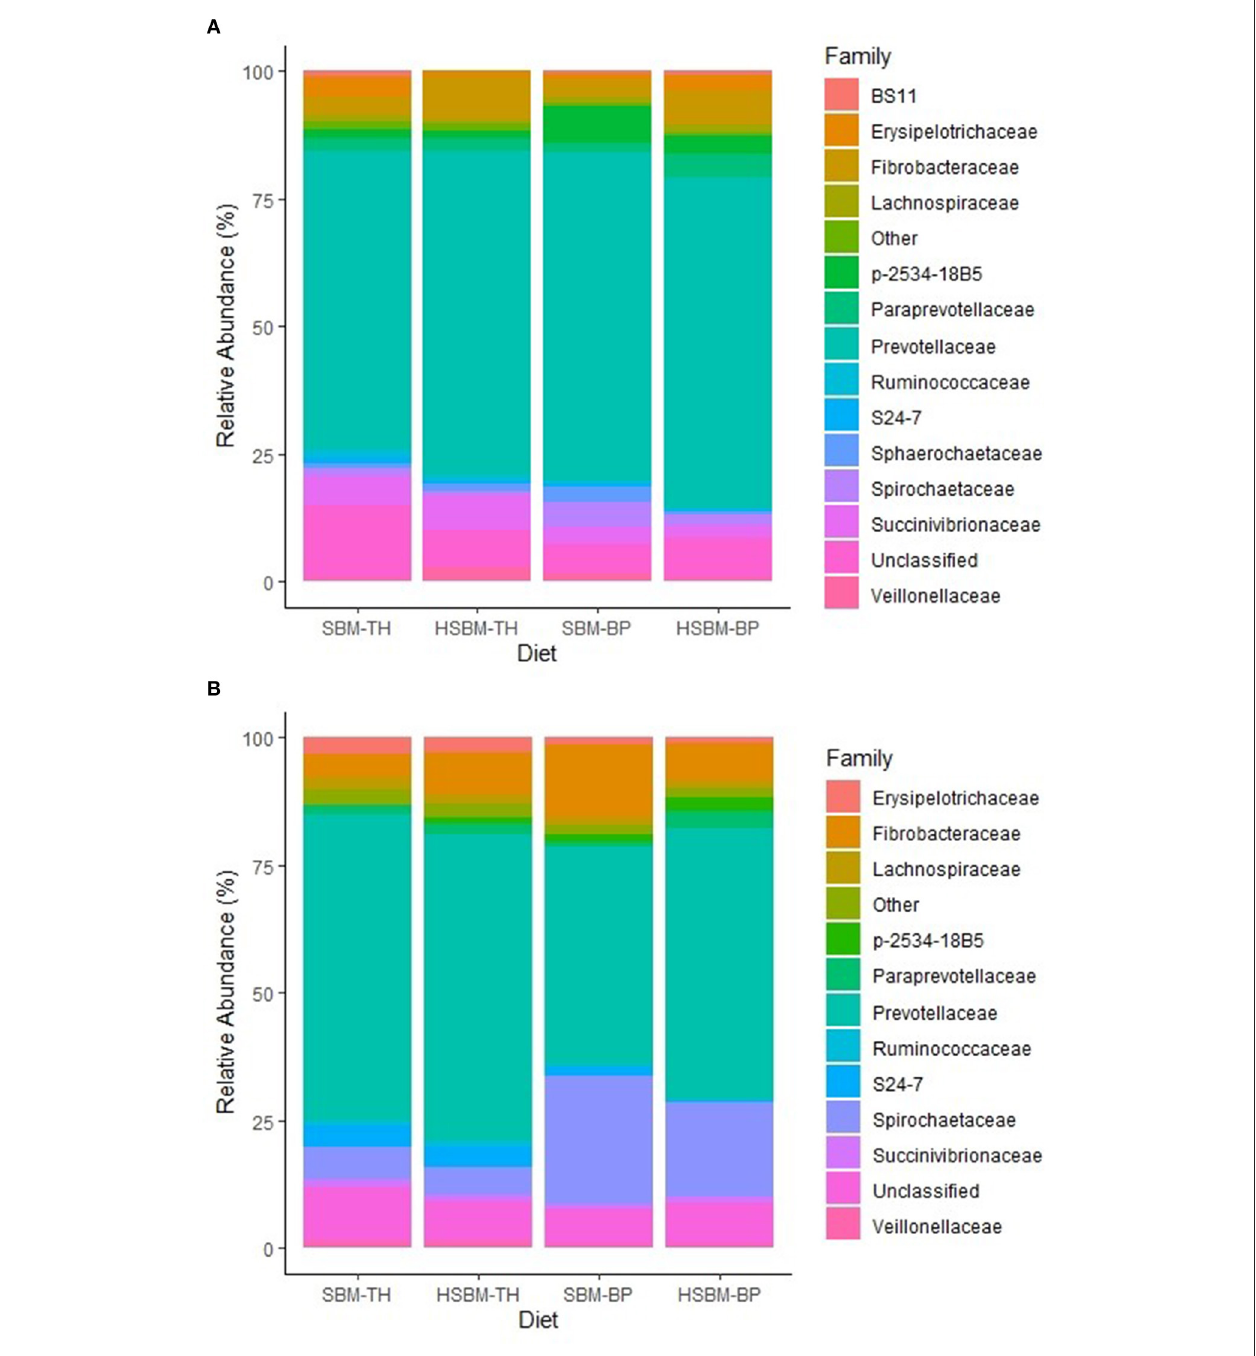
FIGURE 2 | (A) Family-level composition of bacteria identified in the rumen fluid fraction as differentiated by diet. The category “Other” is comprised of taxa with relative abundances < 1.0% for all diets. (B) Family-level composition of bacteria identified in the rumen solid fraction as differentiated by diet. The category “Other” is comprised of taxa with relative abundances < 1.0% for all